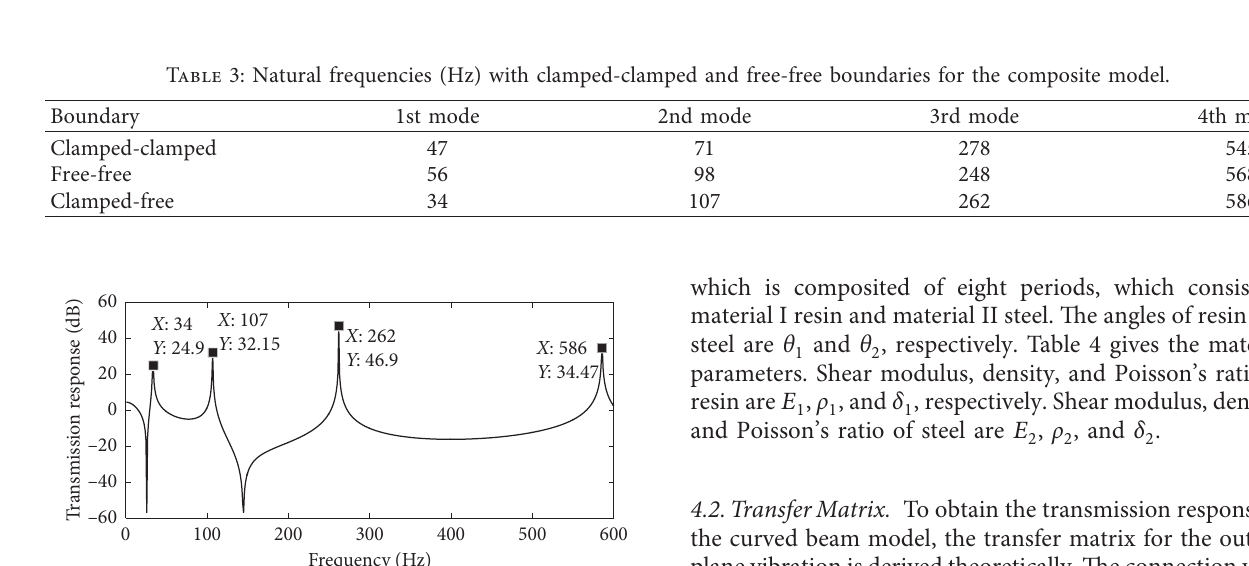
Figure 12: Characteristic curves of natural frequency of out-of-plane vibration for the curved beam, (a) clamped-clamped boundary, (b) free-free boundary, and (c) clamped-free boundary.